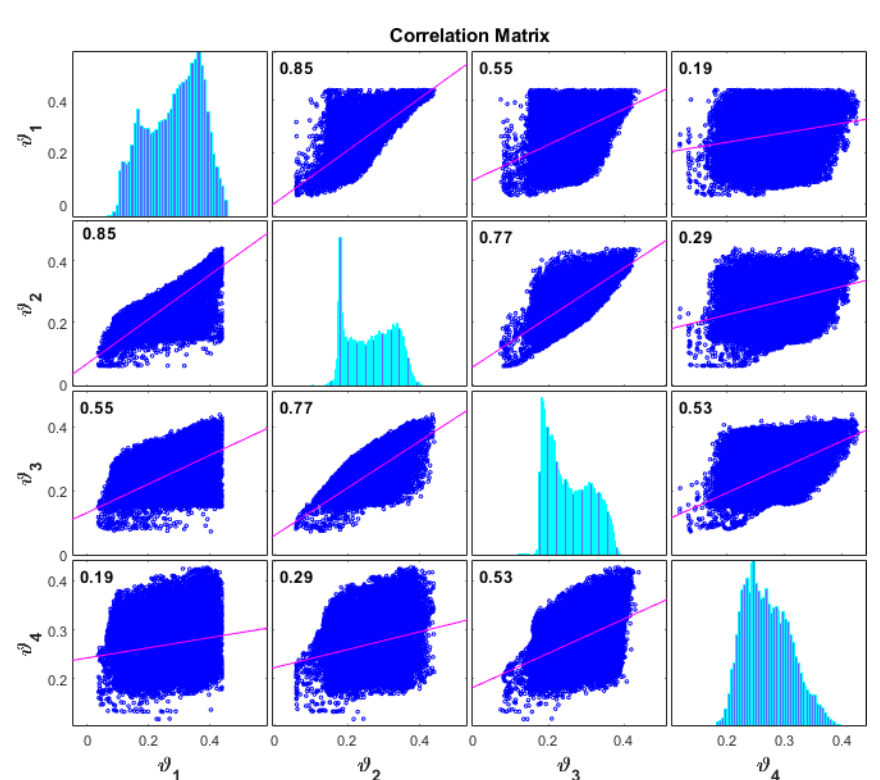
Figure 4. Correlation matrix between the four soil moisture level depths ( ϑ 1 , ϑ 2 , ϑ 3 , ϑ 4 ). Each off-diagonal subplot contains a scatterplot of a pair of variables with a least-squares reference line, the slope of which is equal to the displayed Pearson correlation coefficient. Each diagonal subplot contains the distribution of a variable as a histogram.